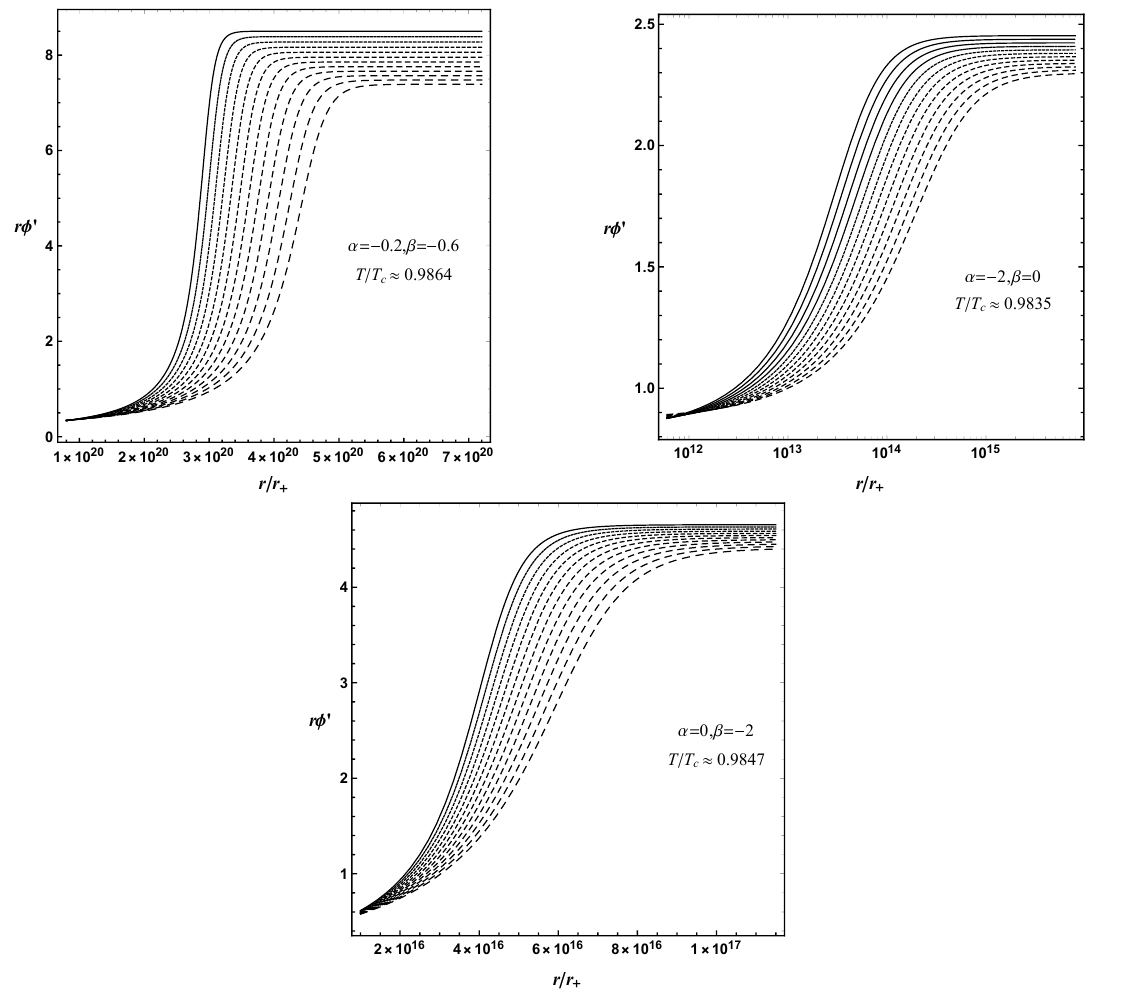
Figure 12 . The value of rφ 0 near the kasner inversion from c to c new = 1 /c at r inv which is the lo- cation of the transition. Form the left hand side and top to bottom, panels are drawn for the Kasner inversion in the range c ≈ 0 . 1664 − 0 . 1914 , c ≈ 0 . 5792 − 0 . 6163 and c ≈ 0 . 4336 − 0 . 4653 ,